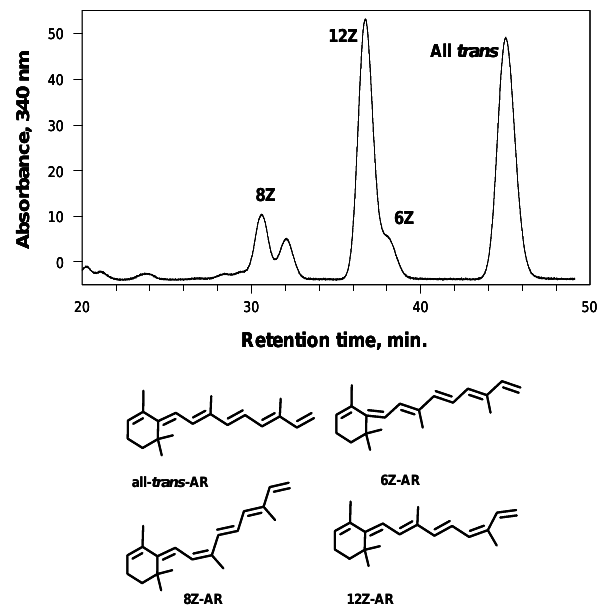
Figure 5: HPLC separation of cis - and trans -isomeric AR.